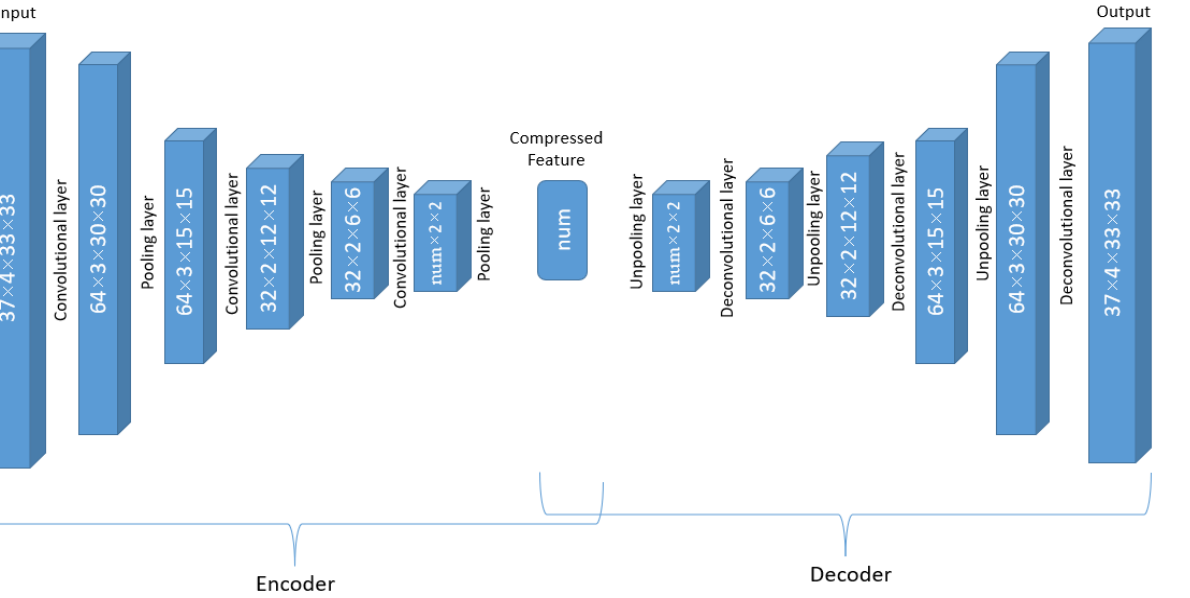
Figure 2. Convolution operation for input with multiple channels. ( a ) 3 × 4 × 4 arrays, ( b ) a three- dimension filter, ( c ) the output arrays after filtering the three channels one by one, and ( d ) the final output array with values being the sum of values on the depth dimension.